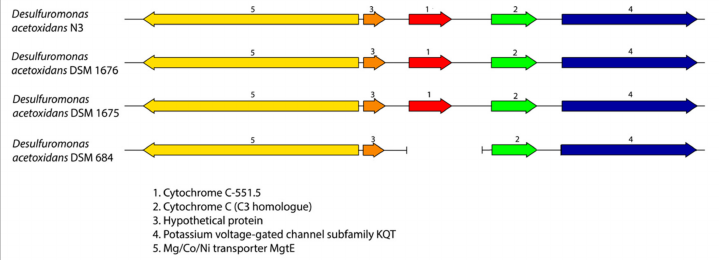
Figure 6. Gene organization comparison around the cytochrome c -551.5 gene in Desulfuromonas genomes. Genes are colored according to protein family